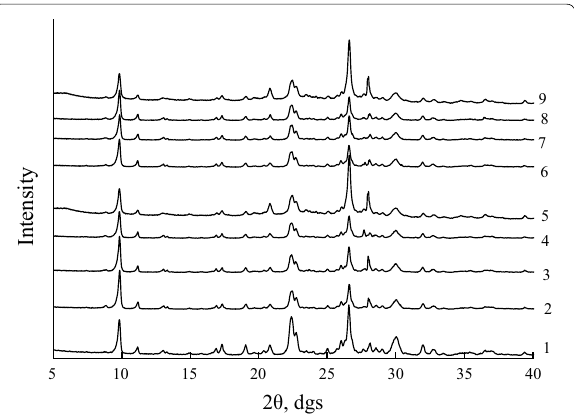
Fig. 1 XRD patterns for natural ( 1 ) and acid-modified 0.25H-CLI ( 2 ), 0.5H-CLI ( 3 ), 1H-CLI ( 4 ), and 3H-CLI ( 5 ) clinoptilolite samples as well as: Pd(II)–Cu(II)/0.25H-CLI ( 6 ), Pd(II)–Cu(II)/0.5 H-CLI ( 7 ), Pd(II)–Cu(II)/1H- CLI ( 8 ), and Pd(II)–Cu(II)/3H-CLI ( 9 )